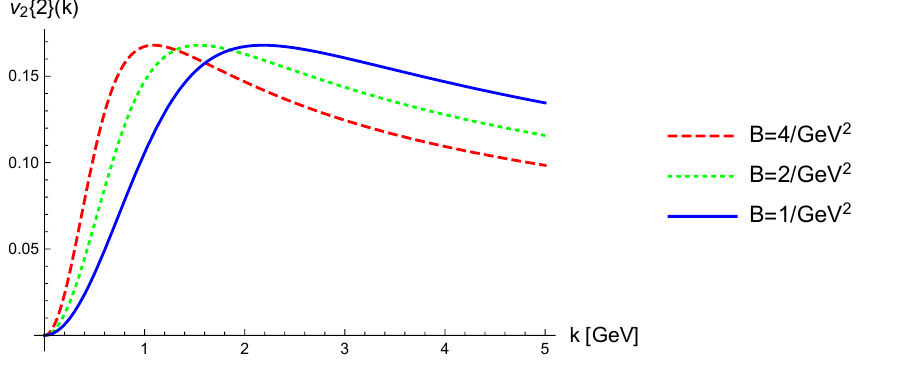
p v 2 f 2 g ( k; k ) evaluated from (3.14) for F (2) corr = 1. 2